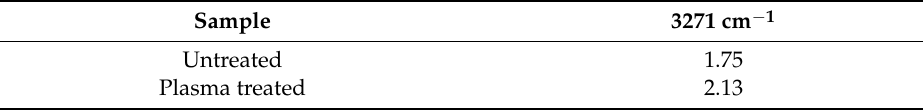
Table 1. ATR-FTIR analysis: peak area.